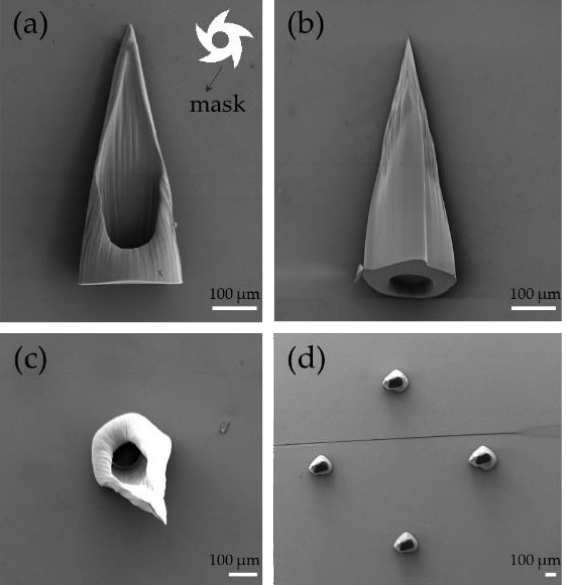
Figure 4. SEM image: ( a – c ) Front, back and top views of the hollow microneedle. The white part shows the detailed pattern of the photomask. ( d ) Microneedle array.